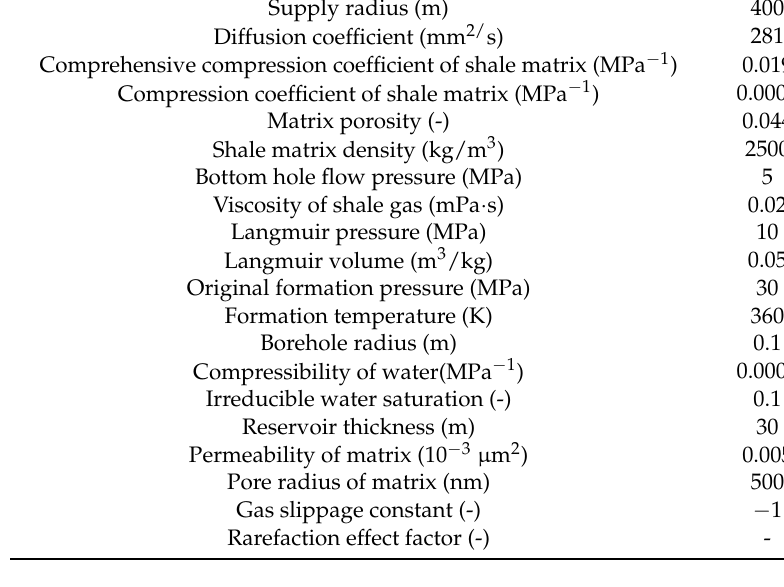
Table 1 . Model calculation basic parameters table.